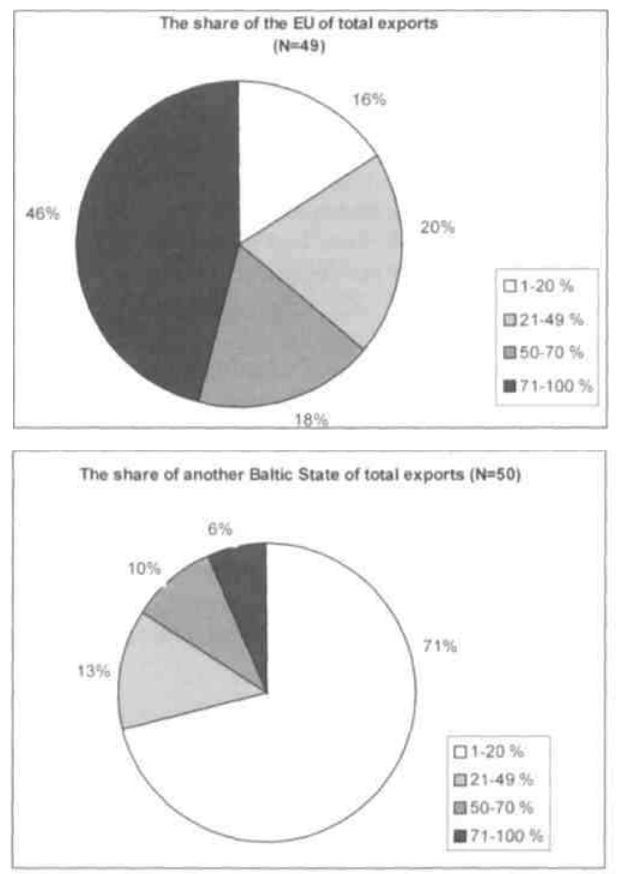
Table 7. The Division of the Baltic Companies' Exports